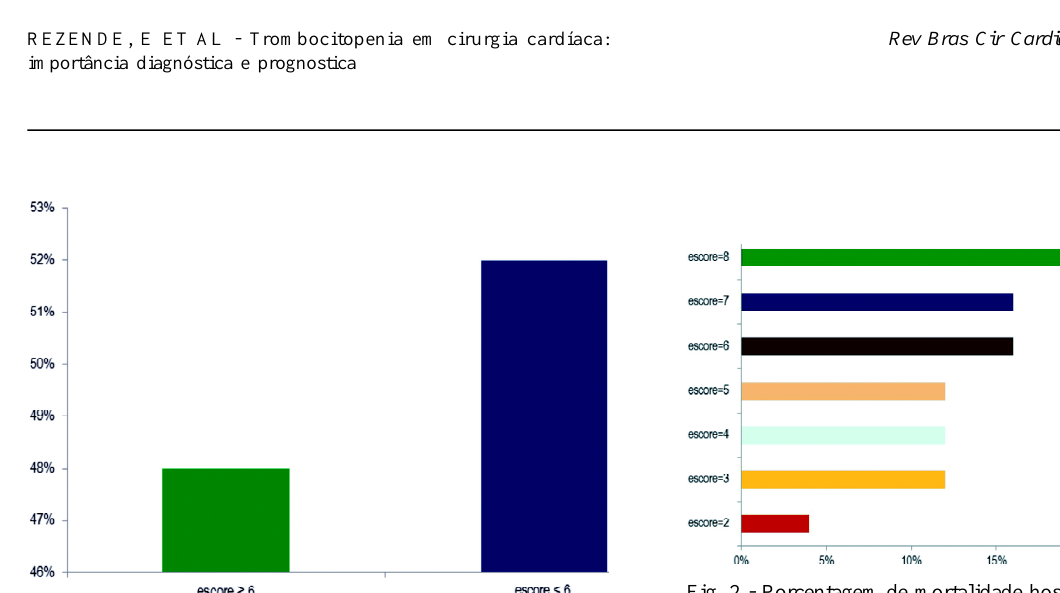
Tabela 3. Comparação entre grupos: escore < 6 e escore > 6. Variáveis Mortalidade na UTI (%) Mortalidade no hospital (%) Idade (anos) Sexo masculino (%) Feminino (%) APACHE II SOFA Poi MODS Poi Duração da cirurgia (horas) Duração da CEC (horas) Tipo de cirurgia (%) Revascularização Válvula Aneurisma Mista; válvula e revascularização HNF